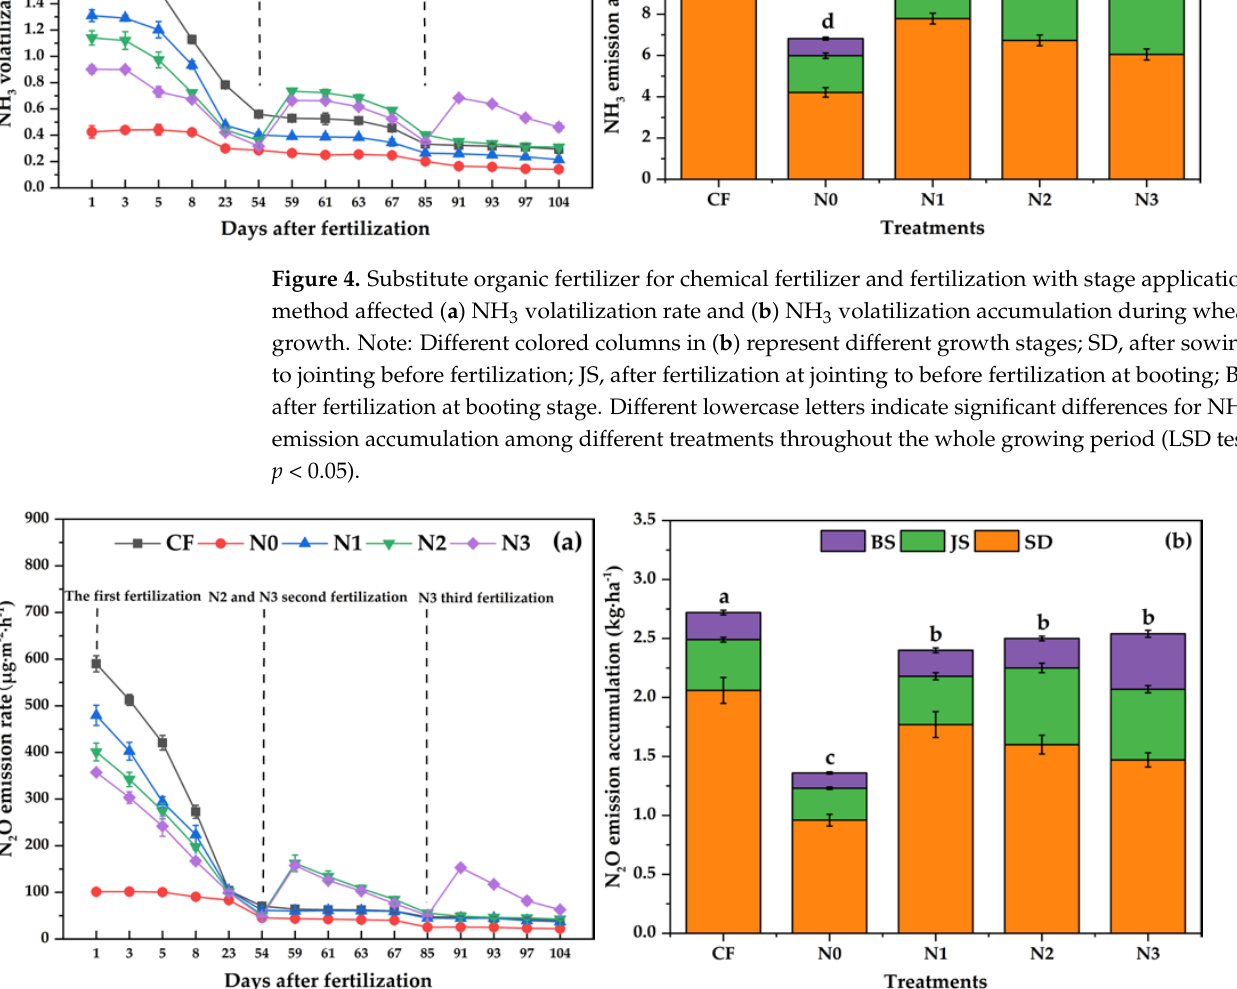
Figure 5. Substitute organic fertilizer for chemical fertilizer and fertilization with stage application method affected ( a ) N 2 O emission rate and ( b ) N 2 O emission accumulation during wheat growth. Note: Different colored columns in ( b ) represent different growth stages; SD, after sowing to jointing before fertilization; JS, after fertilization at jointing to before fertilization at booting; BS, after fertilization at booting stage. Different lowercase letters indicate significant differences for N 2 O emission accumulation among different treatments throughout the whole growing period (LSD test, p < 0.05).